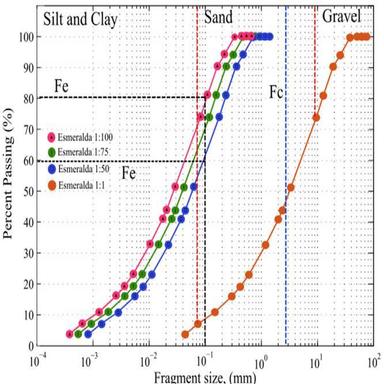
Effect of interparticle forces as a function of material fragment size. Fc: capillary forces; Fe: electrostatic forces.